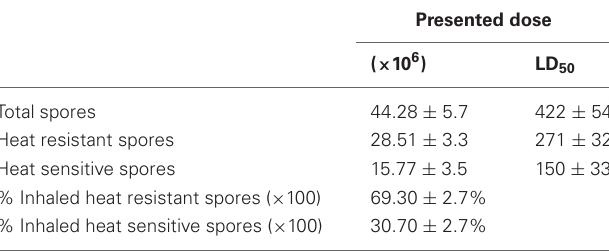
Table 1 | Presented dose of Ames